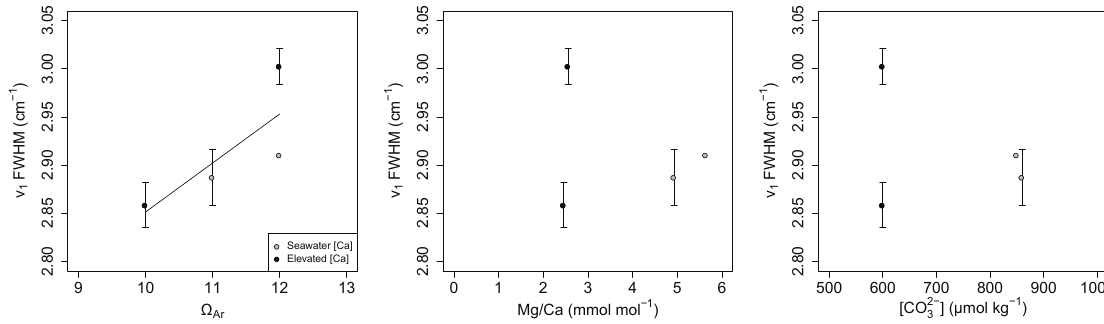
Figure 5. Isolation of (cid:127) Ar , Mg / Ca and [CO 2 − ] controls on true ν 1 FWHM based on manipulation of fluid [Ca 2 + ]. The same data are plotted 3 here as in Figs. 2 and 3, but only over the (cid:127) Ar range of 10–12 because it includes two experiments initiated with seawater [Ca 2 + ] (grey) and two experiments with elevated [Ca 2 + ] (black). With fluid [Ca 2 + ] manipulation, ν 1 FWHM is still sensitive to (cid:127) Ar (a) , but not to Mg / Ca (b) or [CO 2 − ] (c) 3